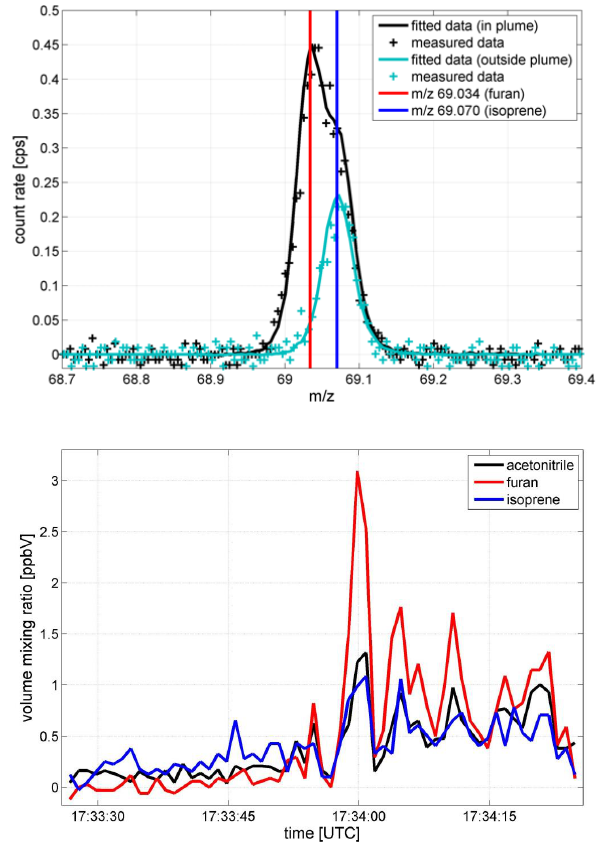
Figure 5. Resolution of isobaric C 4 H 5 O + ( m/z 69.034, protonated Figure 5 . Resolution of isobaric C 4 H 5 O + (m/z 69.034, protonated furan) and C 5 H 9+ (m/z 4 69.070, protonated isoprene) ions (1-minute signal average) measured in an agricultural crop 5 furan) and C 5 H + ( m/z 69.070, protonated isoprene) ions (1min 9 burning plume. The signal obtained outside the plume is included for comparison (top). Time 6 signal average) measured in an agricultural crop-burning plume. series of furan, isoprene (for interferences see text) and acetonitrile obtained during transect 7 The signal obtained outside the plume is included for comparison of an agricultural crop burning plume on September 23, 2013 near Dublin, GA, USA 8 (top). Time series of furan, isoprene (for interferences see text) and (bottom). 9 10 acetonitrile obtained during transect of an agricultural crop-burning plume on 23 September 2013 near Dublin, GA, USA (bottom).